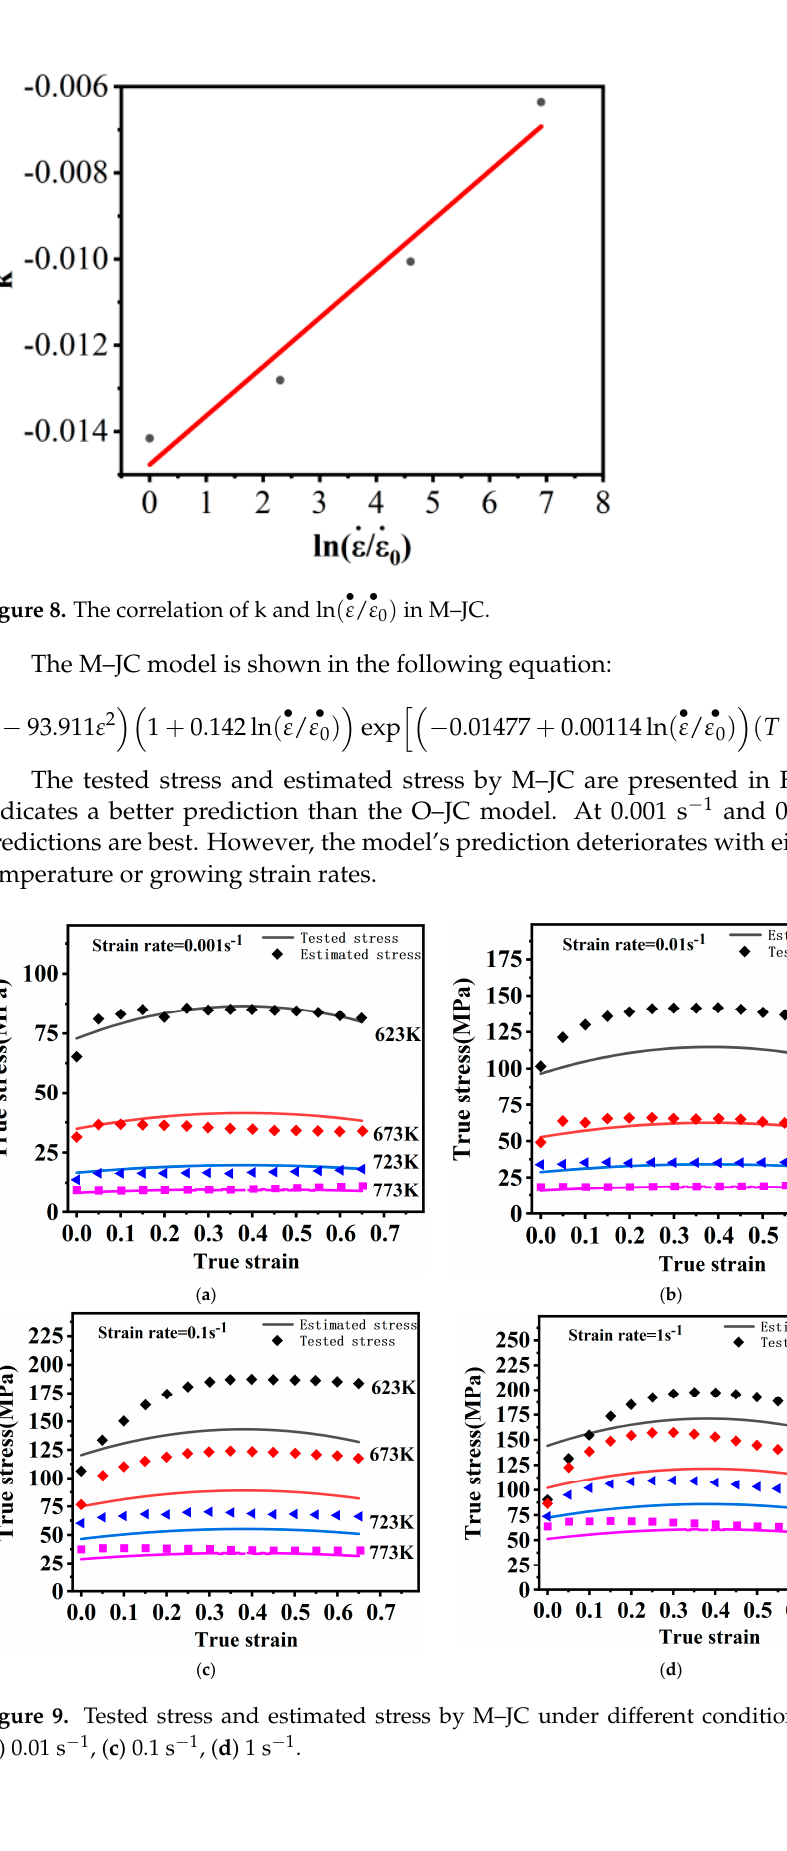
Figure 9. Tested stress and estimated stress by M–JC under different conditions. ( a ) 0.001 s − 1 , ( b ) 0.01 s − 1 , ( c ) 0.1 s − 1 , ( d ) 1 s − 1 .